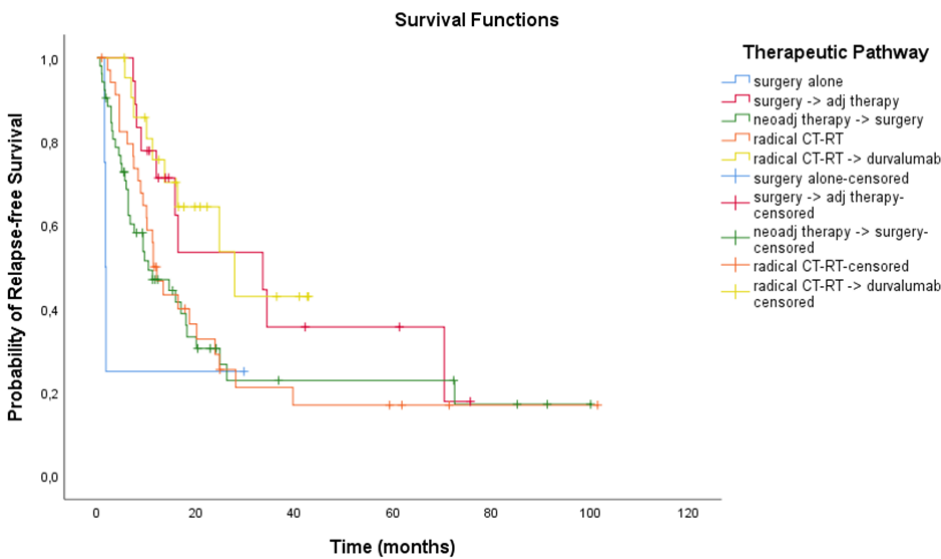
Figure 12. Kaplan–Meier curves of estimated relapse-free survival according to treatment modality in stage IIIB-C patients. CT-RT, chemo-radiation therapy.